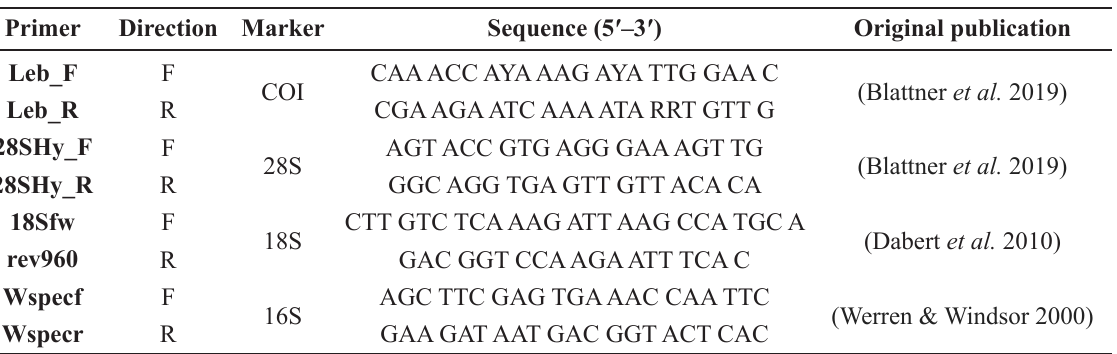
Table 1. Primers used for amplification of DNA fragments